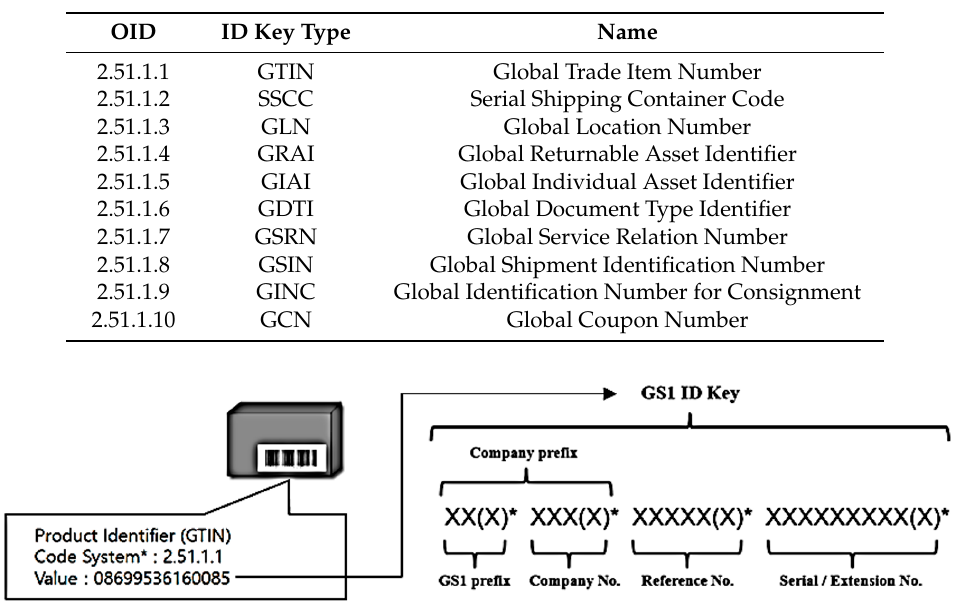
Table 2. GS1 identification key type.